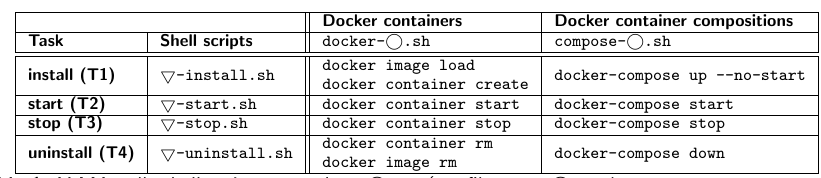
Table 1 ALMA calls shell scripts named 5 - (cid:13) .sh ( 5 : (cid:12)le type, (cid:13) : task; e.g., docker-install.sh ). Simpli(cid:12)cations of the steps called by the according shell scripts are shown for Docker containers, and for compositions of multiple Docker